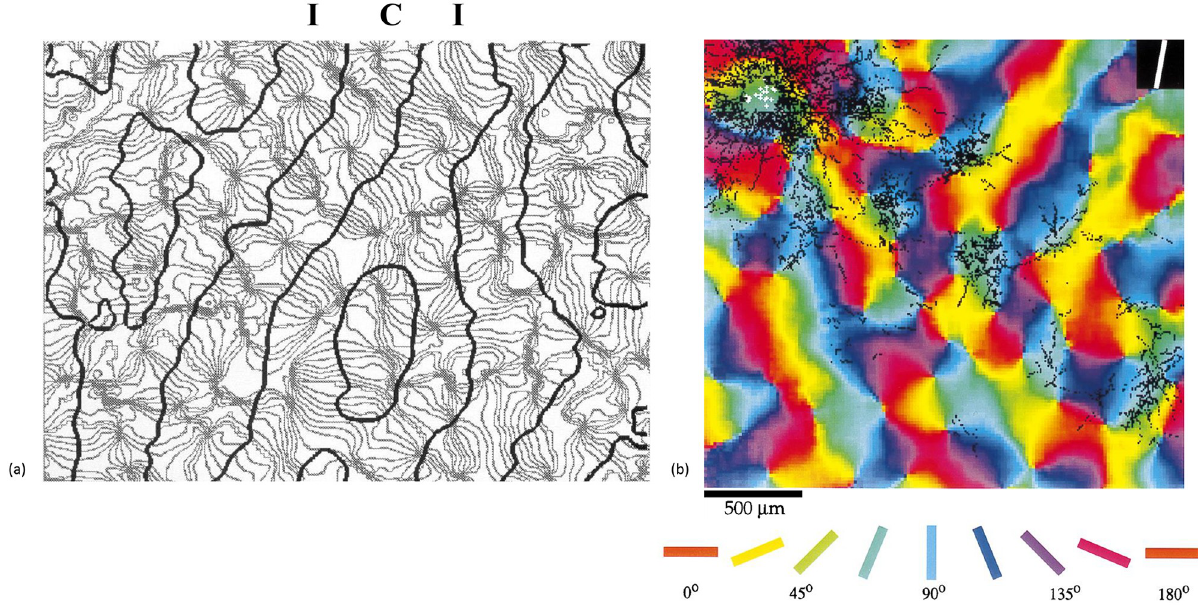
Fig 1. Ocular dominance (OD) and orientation preference (OP) in V1. (a) Combined OD and OP data from macaque. The black contours separate ipsilateral (I) and contralateral (C) OD, while the gray lines are contours of constant OP [12]. (b) Patchy connectivity in tree shrew striate cortex. The white dots represent sites of anterograde biocytin staining injection and the black dots show the bouton distribution (excited areas) to which these points project, showing that projection is chiefly to points of similar OP (indicated by color, as labeled below the figure) beyond the immediate VF projection. The white line in the black square on the top right corner represents the OP direction of the stimulation [13].